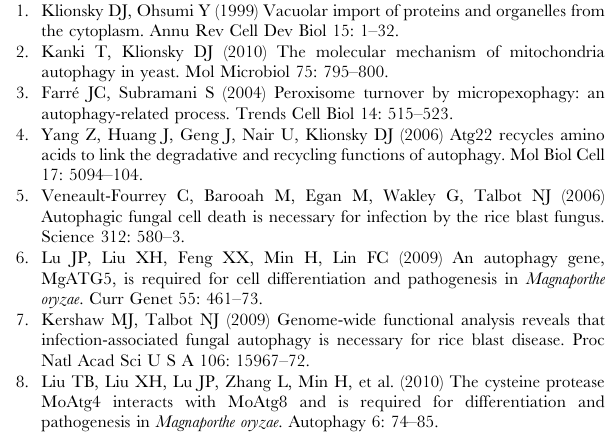
Figure S1 Shapes of nuclei visualized with EGFP-fused histone H2B in wild-type (A) and D Aoatg8 (B) strains. Bar represents 5 m m.